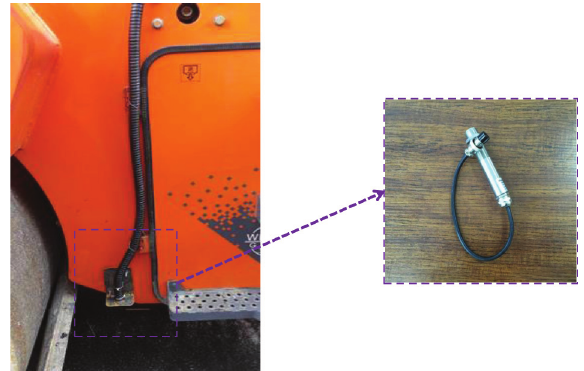
Figure 16: Roller with the infrared temperature sensor. Table 18: Measured initial rolling temperatures of the paving unit of K11+986.2 to K12 +44.1 ( ° C). Stake mark Temperature Stake mark Temperature Stake mark Temperature Stake